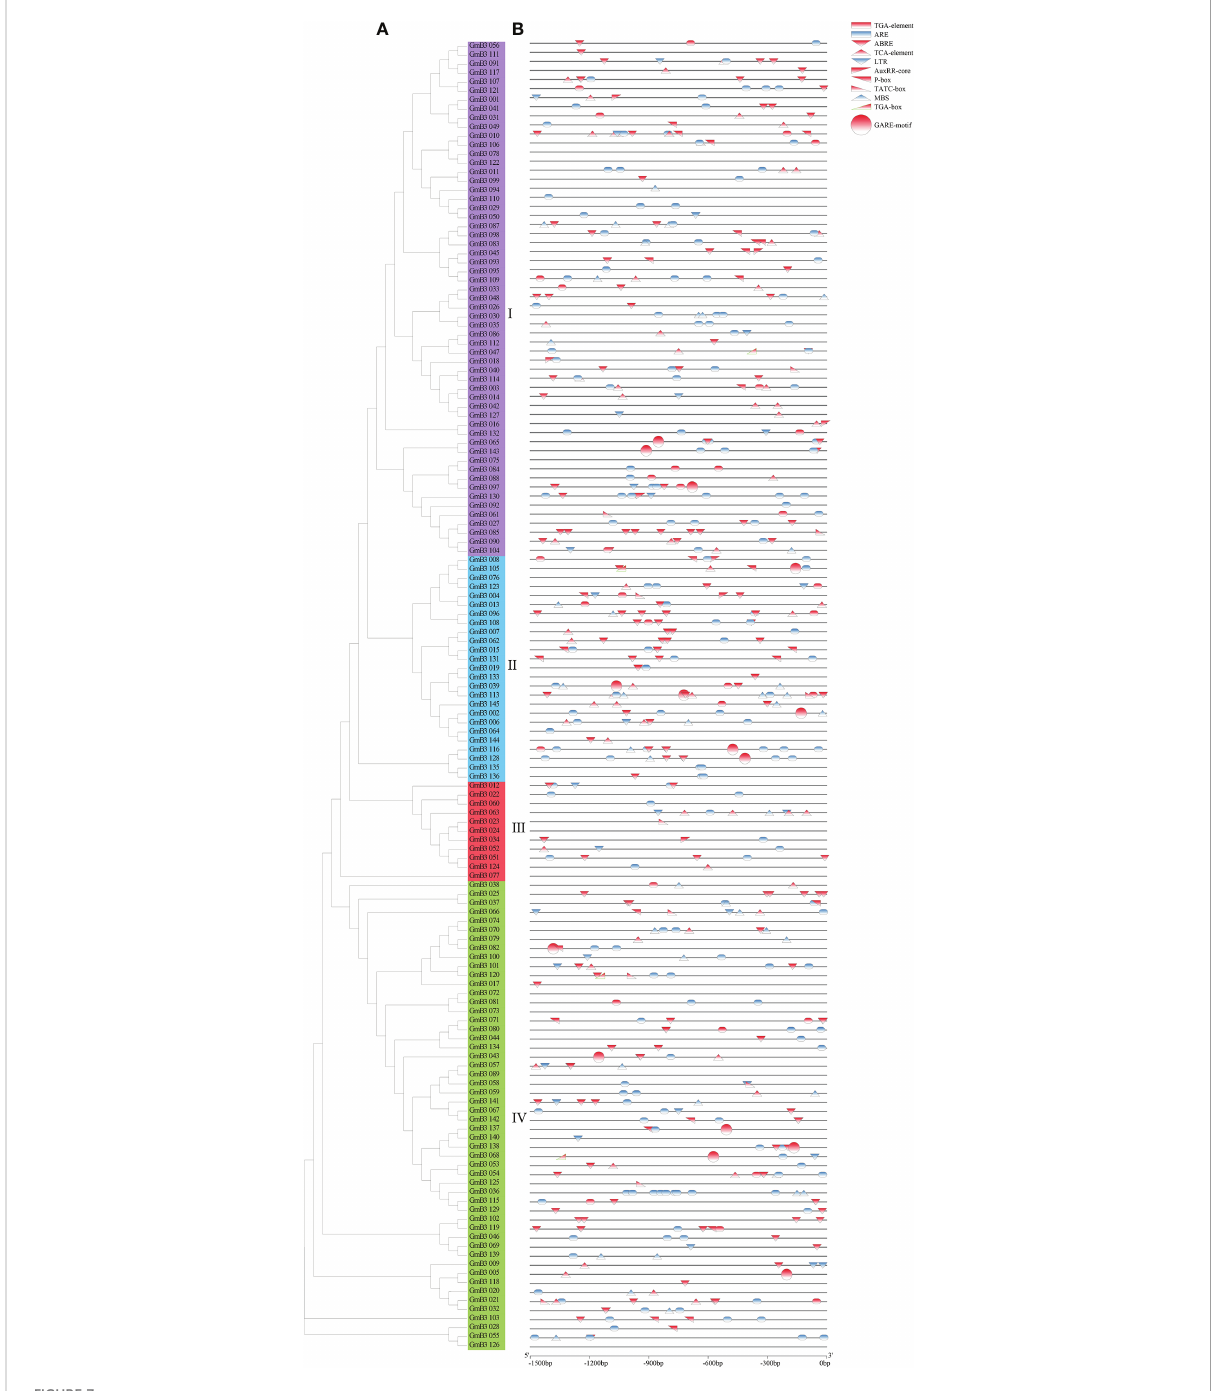
FIGURE 7 Analysis of the cis-acting elements in GmB3 genes. (A) The phylogenetic tree of GmB3s ’ protein. (B) Cis-elements analysis of GmB3 genes. Different colors represented different cis-acting elements and their position in the GmB3